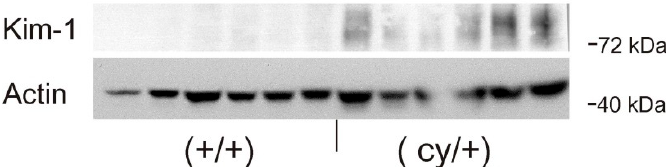
Figure 2. Total protein expression of Kim-1 in adult whole kidney extracts of PKD/Mhm (polycystic kidney disease, Mannheim) rats detected by Western blot. (cy/+): affected kidneys; (+/+): wildtype kidneys. Each lane represents one animal. Blots were reprobed with actin. Kim-1 is only detected in affected kidneys.